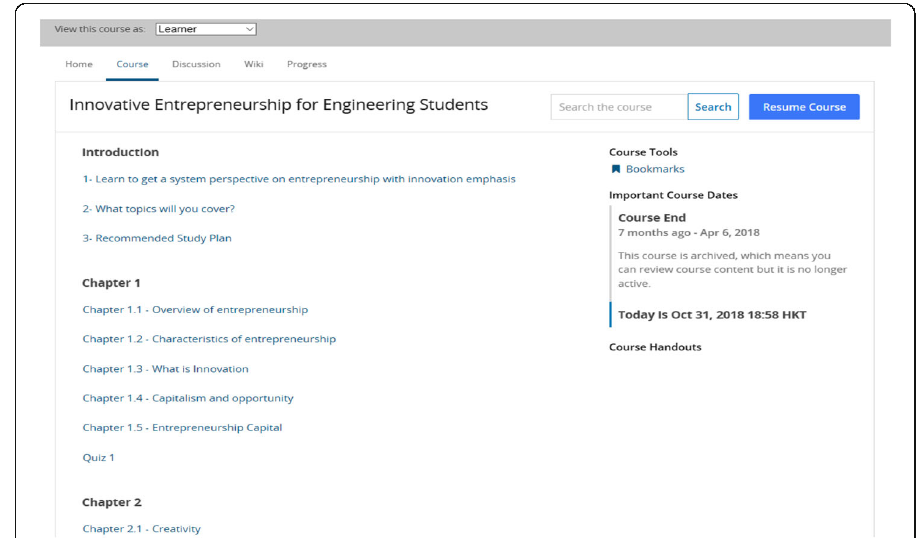
Fig. 2 Interface of the LMS used for the blended learning